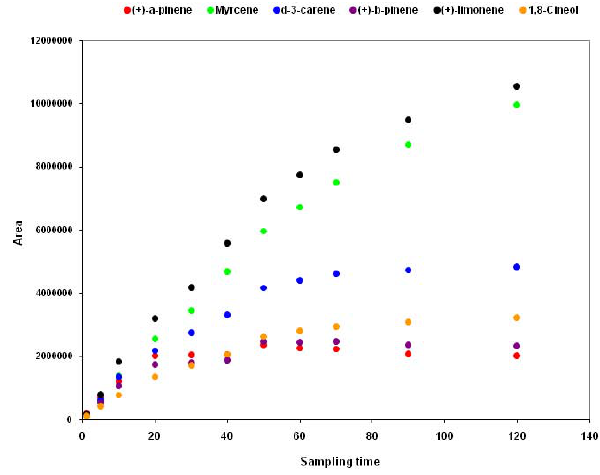
Fig. 5. Extraction kinetics of monoterpenes in 1, 5, 10, 20, 30, 40, 50, 60. 70, 80, 90 and 120min sampling times using DVB-PDMS.